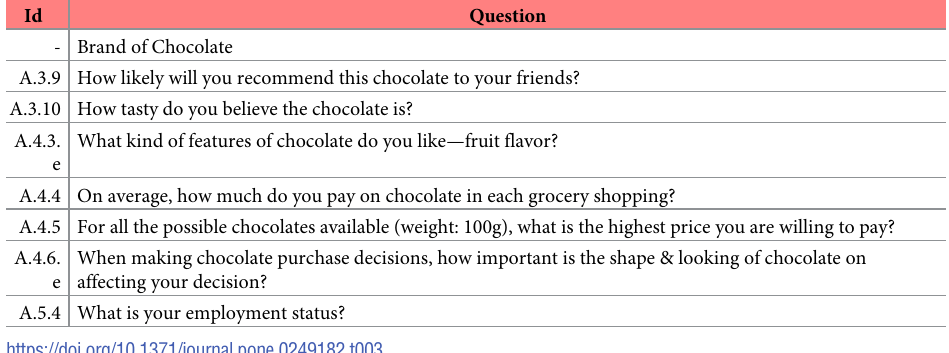
Table 3. Features that Cox-feature-selection considered relevant, at p <